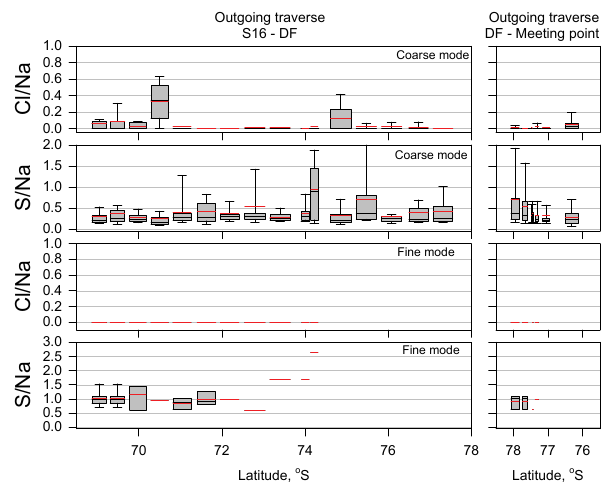
Figure 12. Horizontal features of atomic ratio of Cl/Na and S/Na in coarse and fine modes during the outgoing traverse. In box plots, the top bar, top box line, black middle box line, bottom box line, and bottom bar respectively denote values of 90, 75, 50 (median), 25, and 10%. The red line shows mean